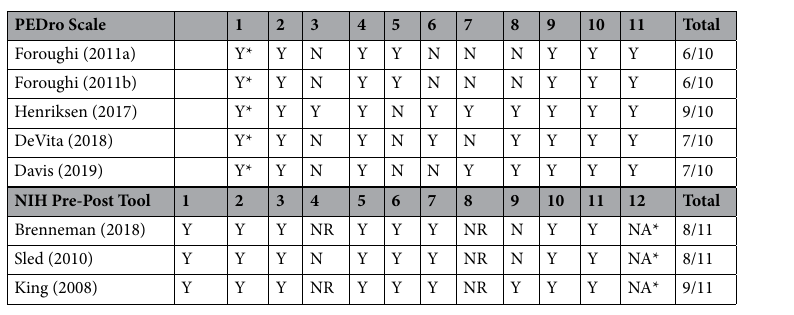
Table 2. Depiction of the risk of bias assessment for included studies. Y yes; N no; NA not applicable; NR not reported. * Not included in total score.